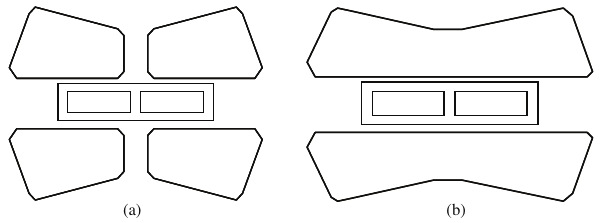
Figure 6. Schematic diagram showing optimum die design for preventing longitudinal welds of hollow